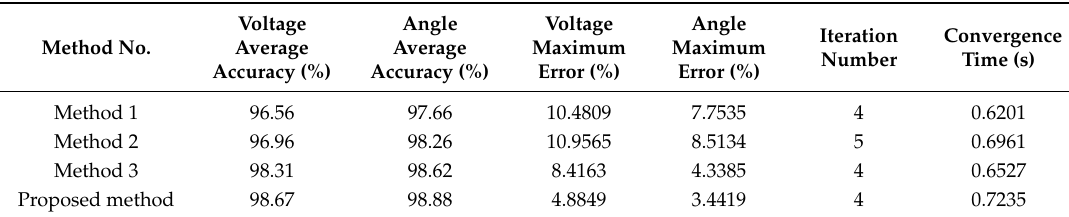
Table 3. The results of state estimation of four methods in 14 bus